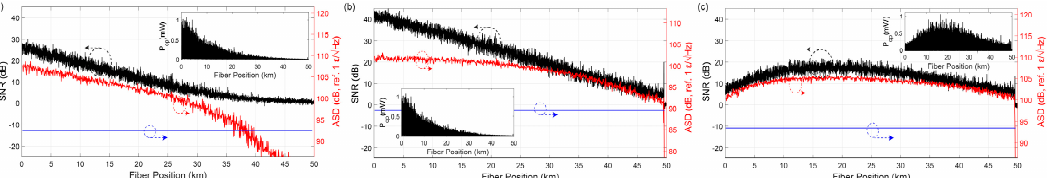
Figure 18. Fibre trace SNR electrical (black), inverted strain ASD noise floor (red), and equivalent laser noise level (blue) along 50 km of fibre, for three di ff erent measurement settings (with 100 ns FWHM pulses ( τ p ) and 1 kHz pulse repetition rate ( f s , ac )): ( a ) Pulse peak power = 200 mW without Raman amplification, without averaging; ( b ) Pulse peak power = 200 mW without Raman amplification, with 40 averages of the optical trace; ( c ) Pulse peak power = 40 mW without averaging, co-propagating Raman pump = 300 mW. Insets show the photodetected traces.